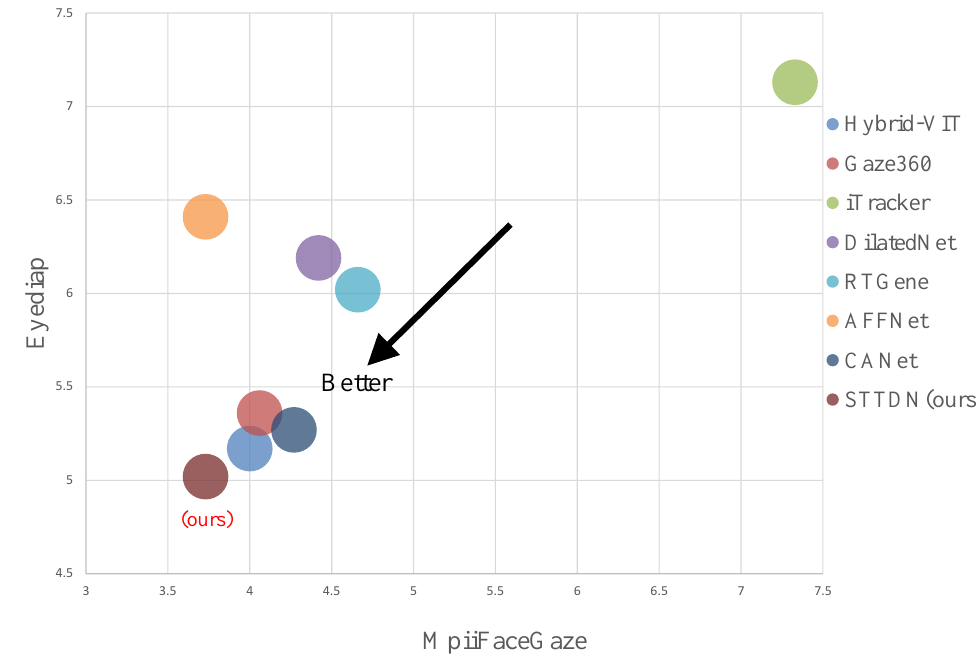
Figure 8. Angular error of the STTDN, and comparison methods on the MPIIFaceGaze [20] and Eyediap [42] datasets. We recorded the angular error of the MPIIFaceGaze on the horizontal axis, and the angular error of Eyediap on the vertical axis. The performance was better when the position was closer to the bottom left